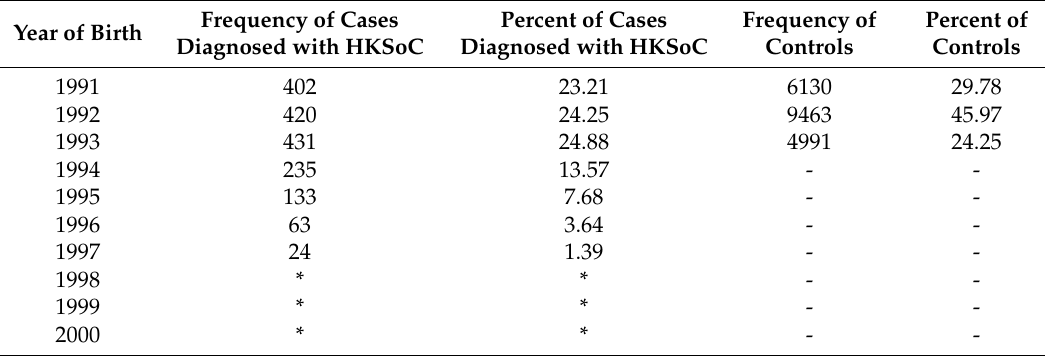
Table 1. A summary of the year of birth of individuals diagnosed with hyperkinetic syndrome of childhood (HKSoC) and controls within the Vaccine Safety Datalink